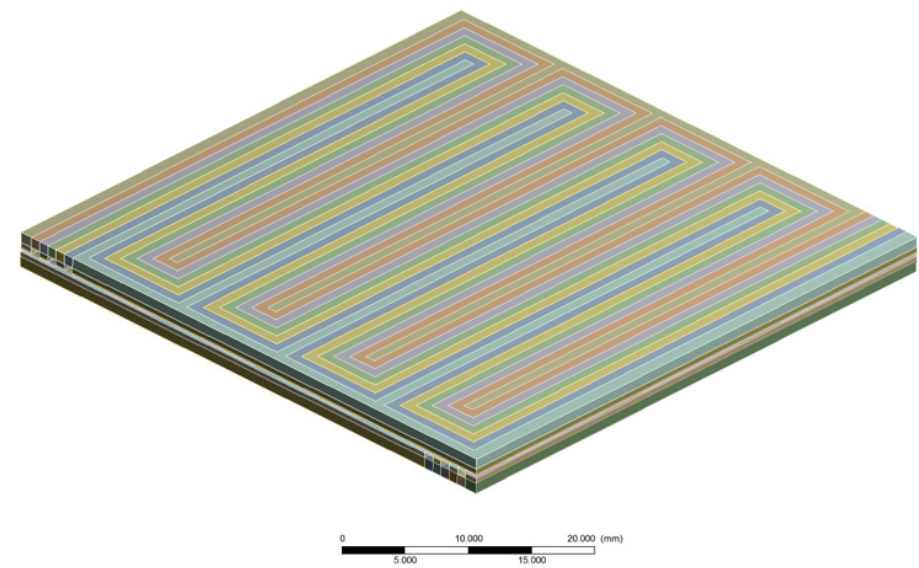
Figure 3. Decomposed geometry of the anode and cathode flow fields.